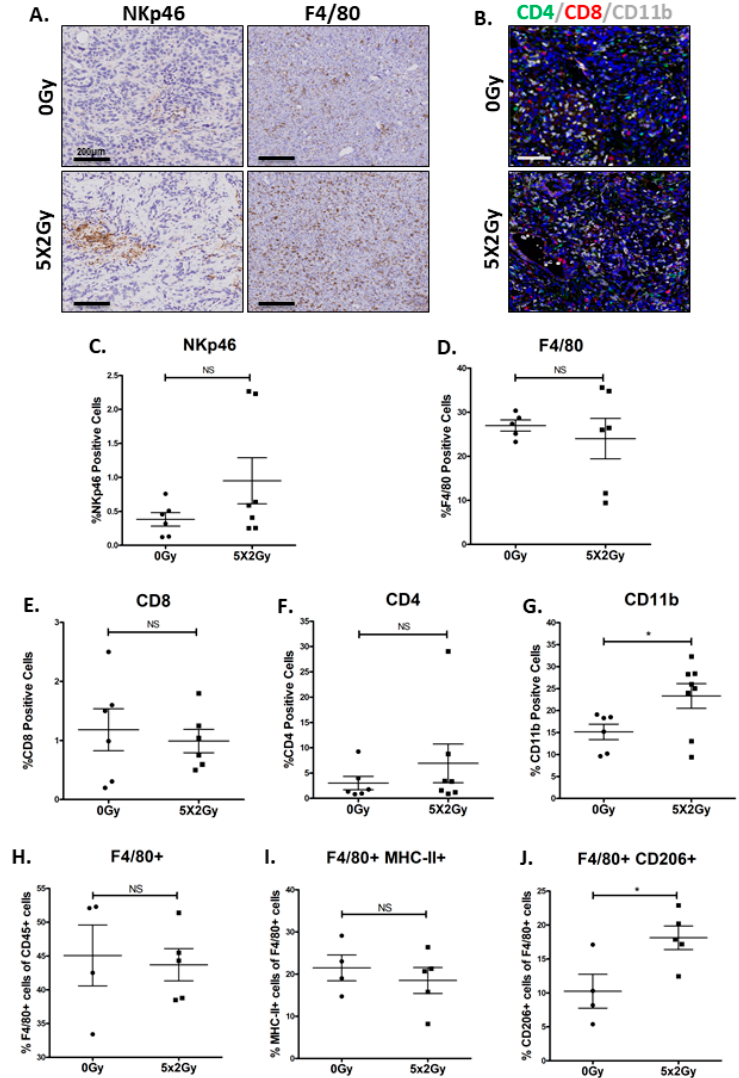
Figure 5. Radiotherapy resulted in an increase in immunosuppressive myeloid cells infiltrates and macrophages acquiring an M2 phenotype in the DVL3 tumours. ( A ) Representative immunohistochemical staining for natural killer T-cells (Nkp46) and macrophages (F/480) in DVL3 tumours. Nkp46 staining was sparse and mainly localised around the necrotic areas within the tumour. ( B ). Representative multiplex staining images for CD4 (green), CD8 (red) and CD11b (white) in the DVL3 tumours revealing an increase in CD11b staining in the irradiated tumours. Quantification of immunohistochemical staining comparing untreated (0Gy) and tumours treated with fractionated radiotherapy (5 × 2Gy) showed no significant difference in ( C ) NK-T-cells (NKp46), ( D ) macrophages (F4/80), ( E ) cytotoxic T cells (CD8), or ( F ) helper T cells (CD4). ( G ) However, radiotherapy treatment did induce a significant increase in myeloid cells (CD11b+) in the irradiated tumour. ( H ) Flow cytometry analysis for macrophages (gated as CD45+/F480+) cells showing no significant increase in proportion of cells in the irradiated tumours. ( I ) Flow cytometry analysis for MHC-II+ cells (M1 marker) on macrophages gated as (CD45+/F480+/ MHC-II+) in the irradiated tumours ( J ) Flow cytometry analysis for CD206 (Mannose receptor, an M2 marker) on macrophages gated as (CD45 +/ F480 +/ CD206 + ) revealing a significant increase in CD206 + staining in the irradiated tumours (gating strategy in Supplementary Figure S5). Data represents mean ± SEM of n = 4–8 independent murine tumors as indicated by points on each graph. * denotes p ≤ 0.05, NS denotes non-significant, as determined by Student’s t -test (immunohistochemistry) or Mann-Whitney, nonparametric testing (flow